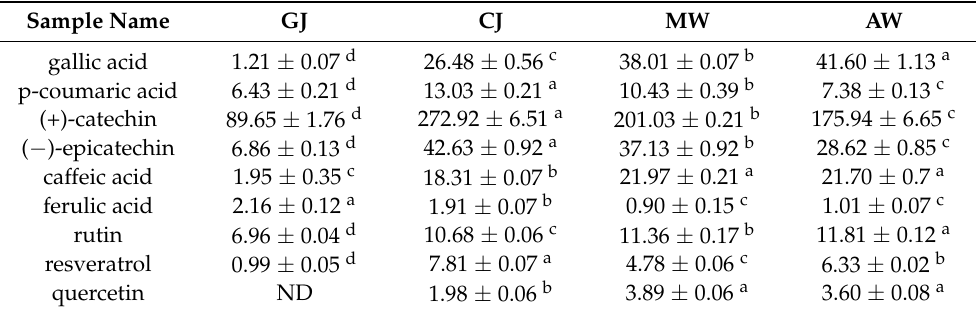
Table 2. Effects of winemaking on phenolic compounds